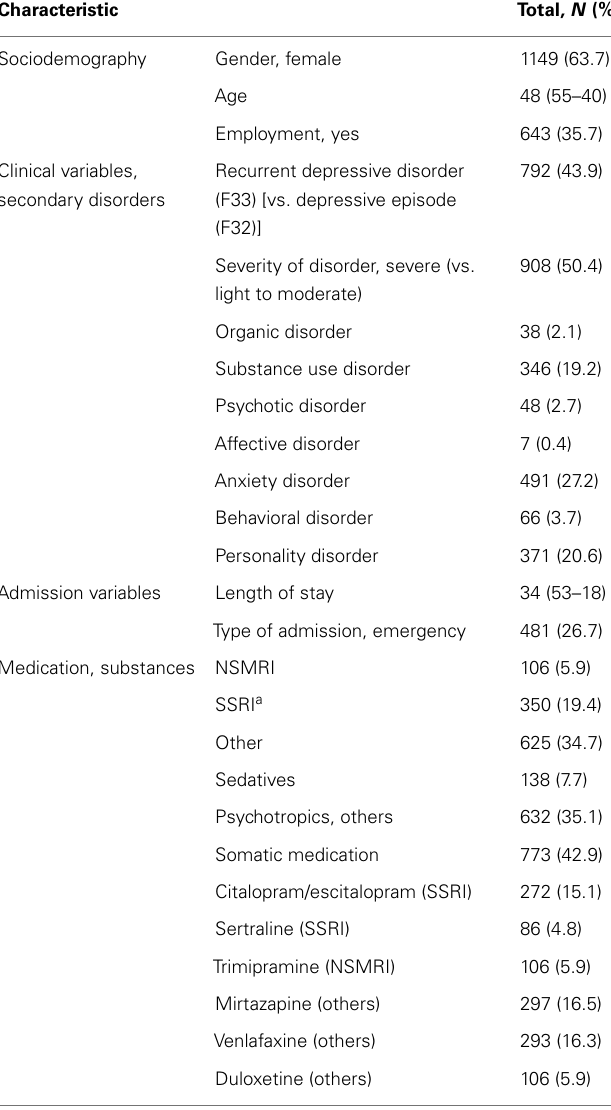
Table 1 | Sample characteristics at time after discharge from index hospitalization